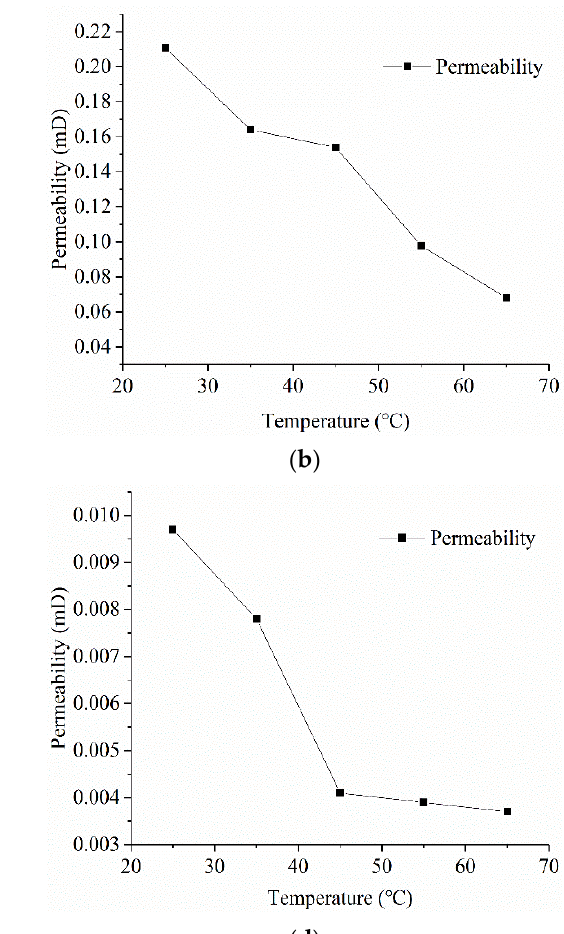
( d ) subcategory II 2 sandstone.